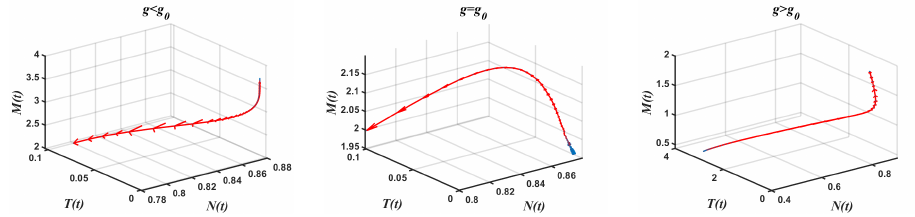
Figure 4. Phase portraits of model (1) for various g -values corresponding to Figure